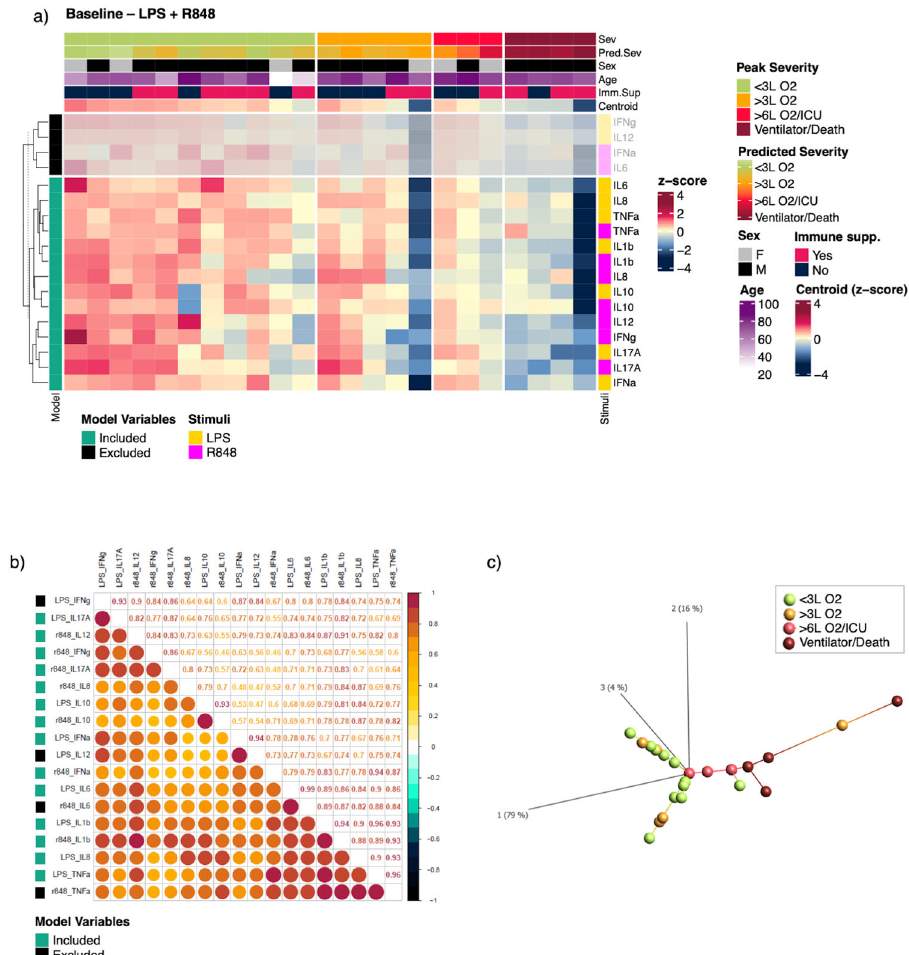
Fig. 5 A stimulation signature based on LPS and R848 stimulated cytokine responses at baseline associated with peak severity. a Combined LPS and R848 stimulated cytokine variables at baseline. Each column represents a patient, each row represents a stimulus-cytokine variable. Columns are grouped by future peak severity, rows are grouped by inclusion/exclusion in the LPS + R848 model. Hierarchical clustering by Euclidean distance as